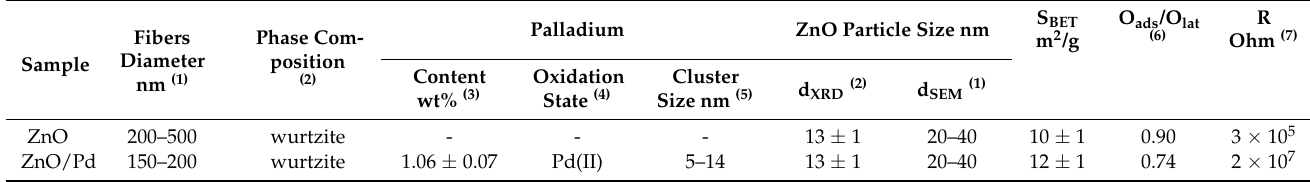
Table 1. Summary of ZnO and ZnO/Pd nanofibers characteristics [36].